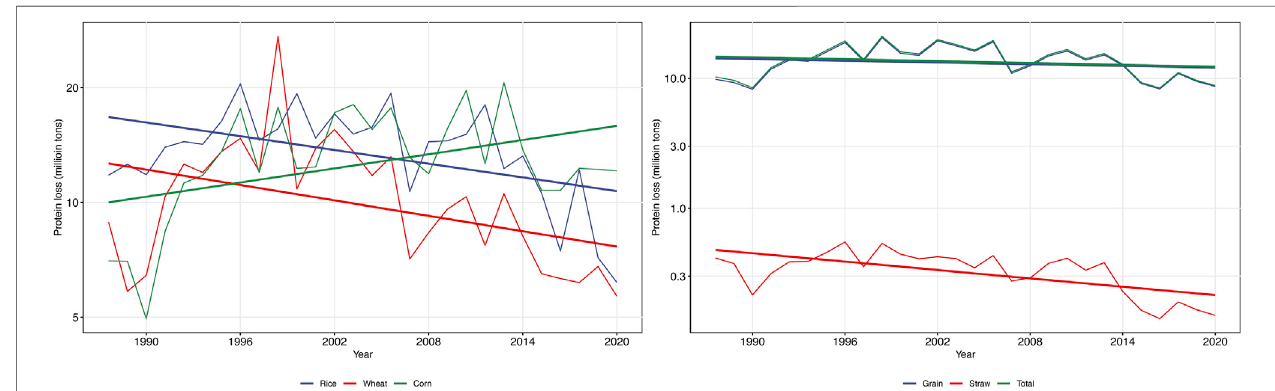
FIGURE11| Trendsinproteinlossesinmaize,rice,wheat,grain,strawandtotalduetonaturaldisastersinagriculturalareasofChina,1988 – 2020.Linesrepresent the fi tted linear regression trends.